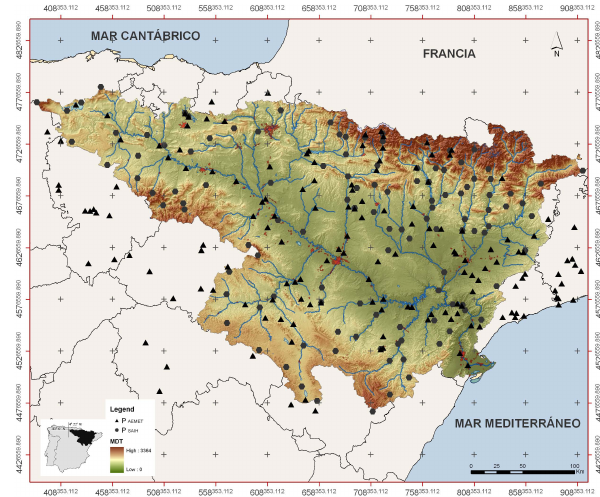
Fig. 1. Digital Terrain Model of the study area showing the spatial distribution of the rainfall gauges used in the study (UTM coordi- nates). P AEMET indicates daily rainfall data series for period 1955– 2006 provided by the Spanish Meteorological Agency. P SAIH in- dicates the 15’ rainfall data series for period 1997–2006 provided by the Automatic Hydrologic Information System of the Ebro river